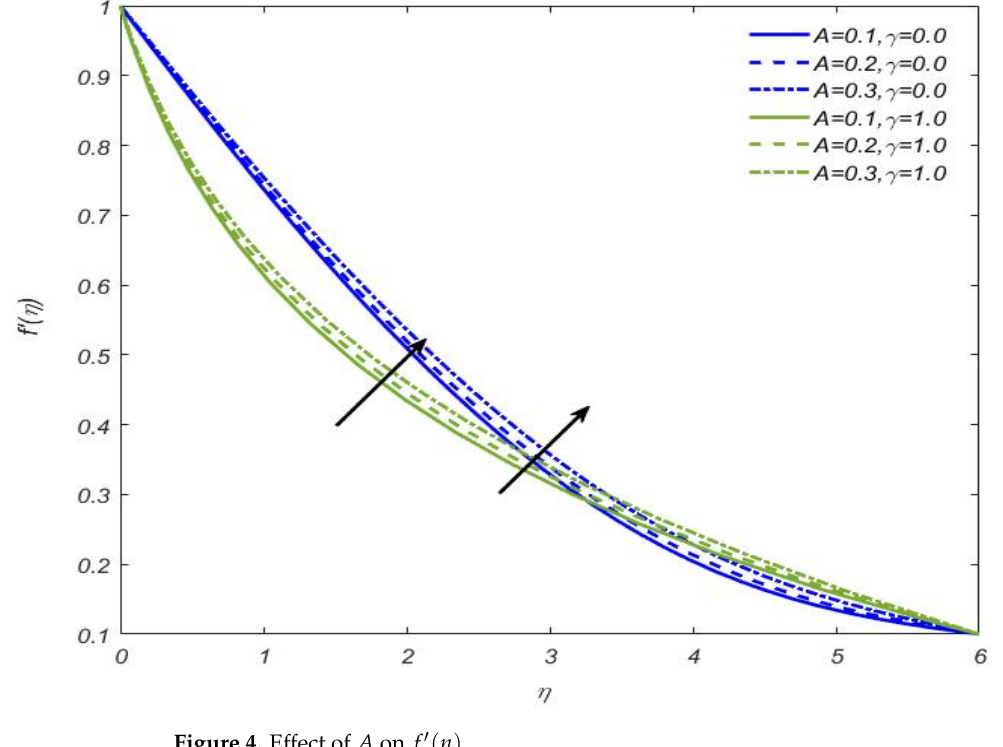
Figure 4. Effect of